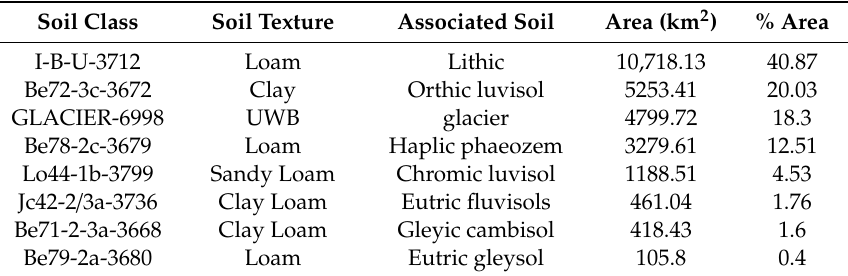
Table 2. Soil classification in the study